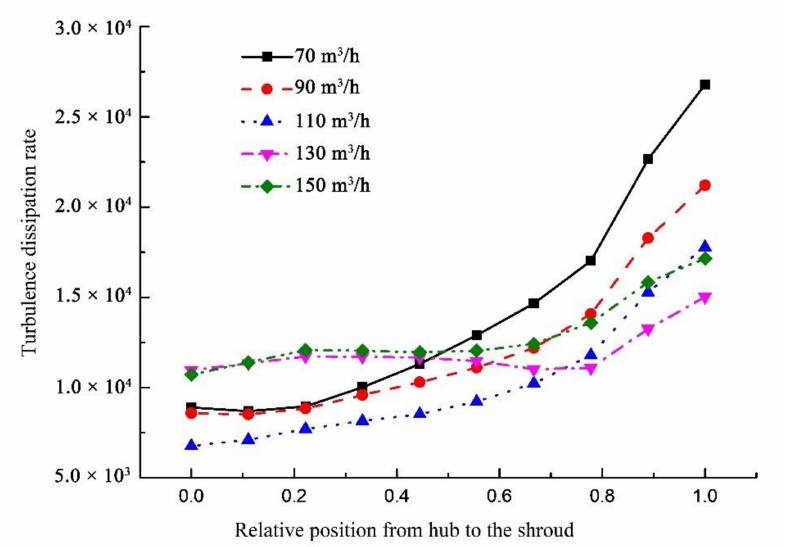
Figure 15. The variation of turbulence dissipation rate from the hub to the shroud of the first impeller inlet section under different flow